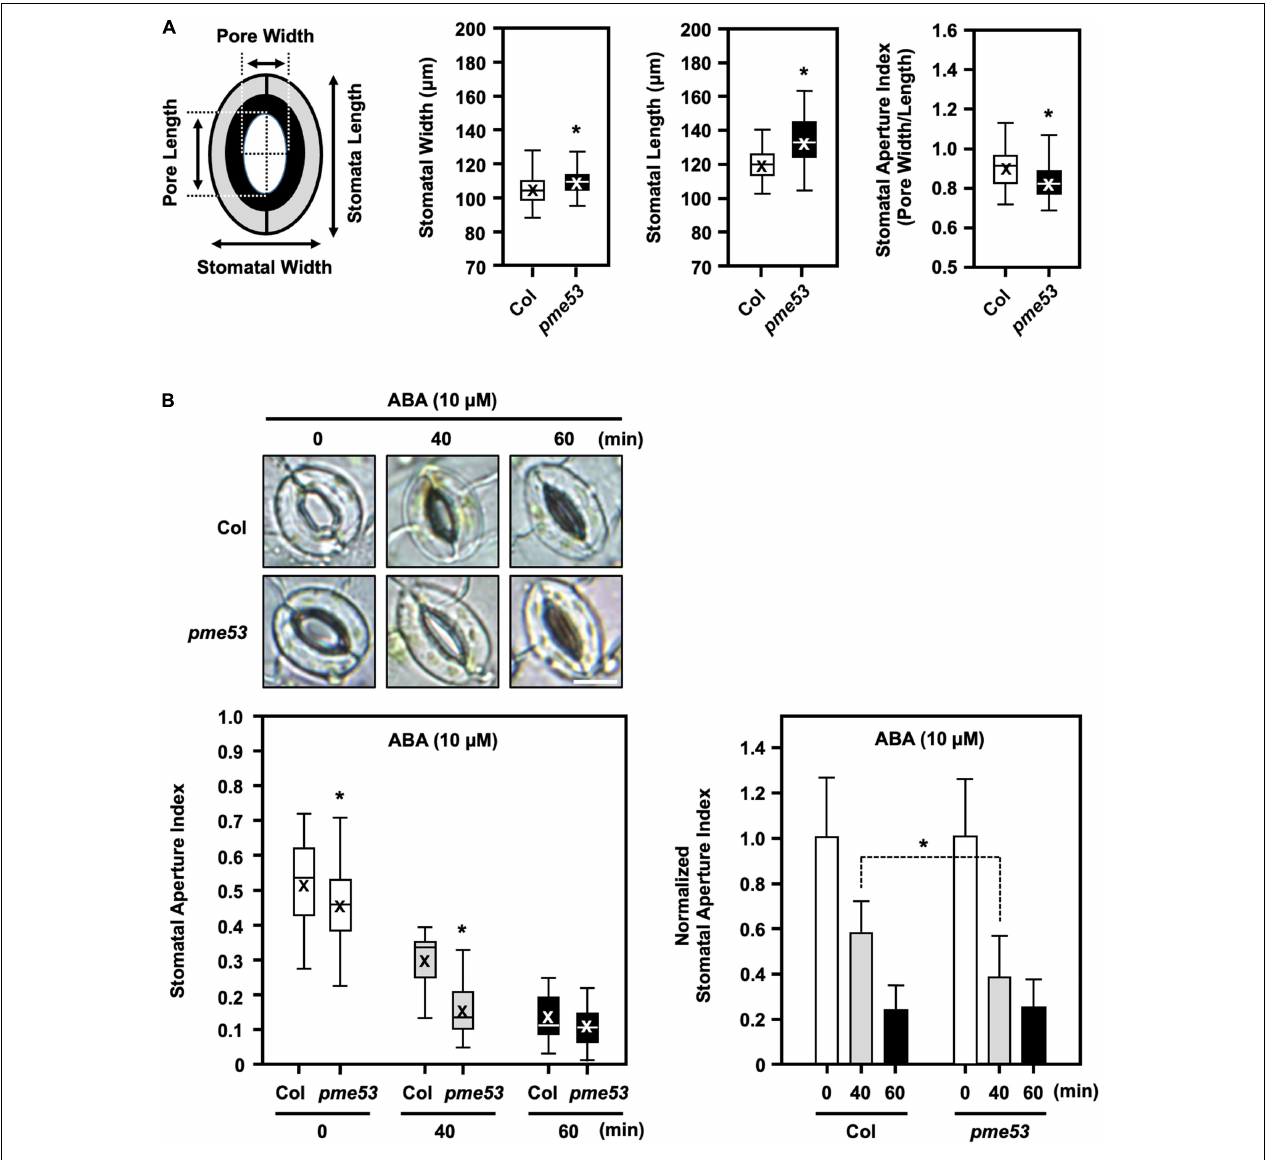
FIGURE 5 | Stomata maximal-opening ability and movement in pme53 mutant plants in response to ABA. Schematic representation of stomata pore measurement. (A) Epidermis peels of the fully expended 4-week-old plants incubated in an opening buffer under light for 3 h then the stomata maximal-opening ability was analyzed stomatal length ( µ m) and width ( µ m), as well as the stomatal aperture index (pore width/length), were measured. n > 80 stomata. (B) Stomatal movement in response to 10 µ M ABA for 40 or 60 min was measured. The stomata aperture index and the normalized stomata aperture index were measured. n > 80 stomata. Representative images of stomata were shown. Bars = 10 µ m. Data are mean ± SE of three biological replicates. *Significant at P < 0.05 compared with the Col (ANOVA Tukey-Kramer post hoc test).